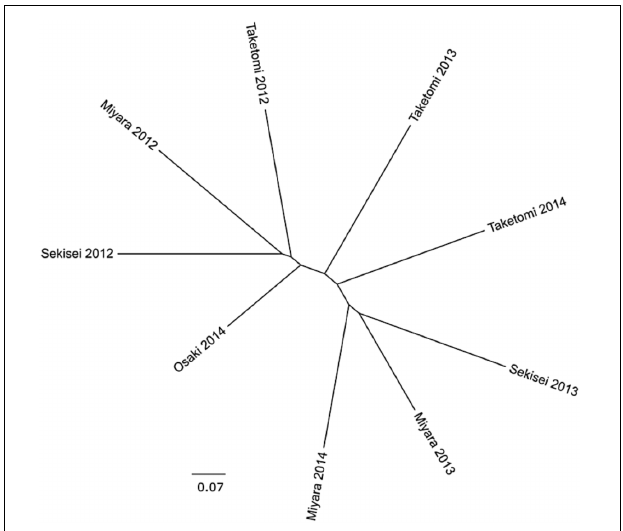
FIGURE 4 | The microbial communities of Ishigaki coral reef seawater have similar genetic compositions. Cladograms representing the fraction of cross-contigs (i.e., shared contigs that contain reads from two or more metagenomes) after